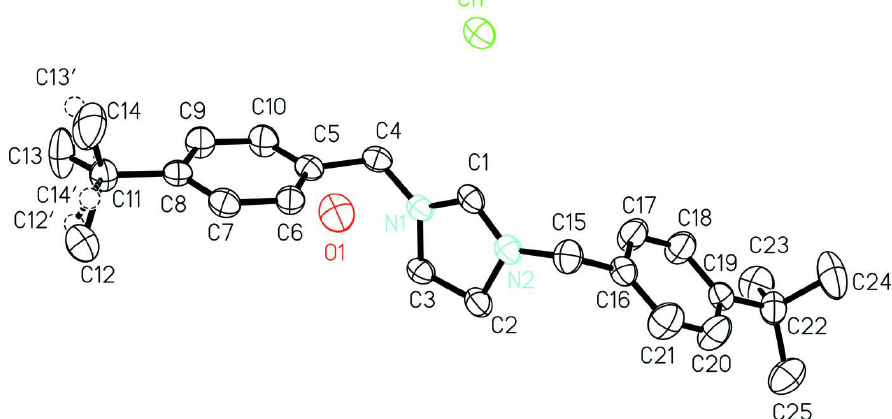
The molecular structure of the title compound, showing the atom-numbering scheme and displacement ellipsoids drawn at the 50% probability